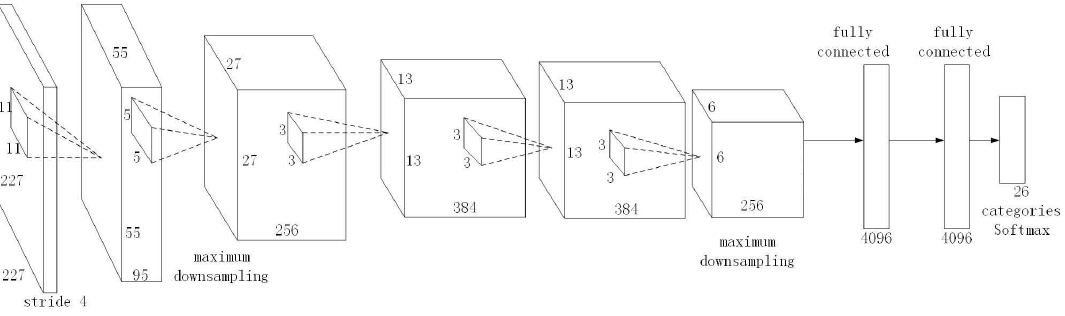
Figure 13. sceNet network